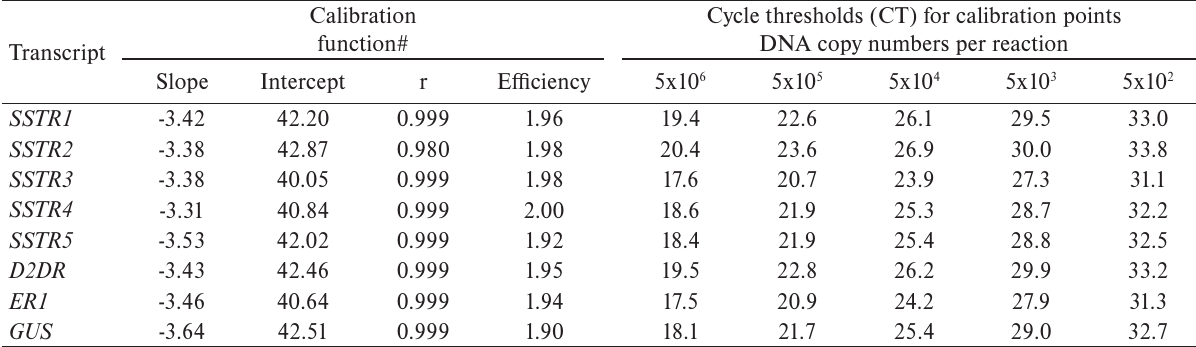
Table 2. Parameters of calibration